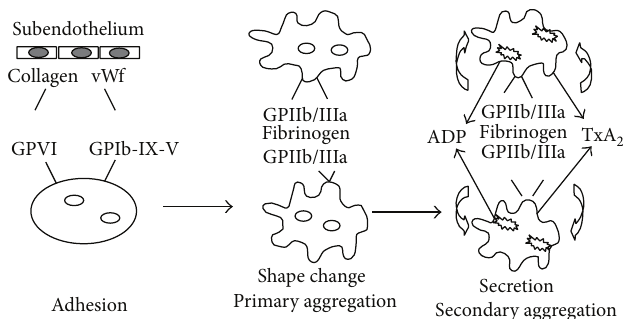
Figure 5: After an injury in the vessel wall, activation of platelets begins to start. It involves its adhesion to the subendothelium surface. Interaction between receptors like GPIb-V-IX, GPIa-IIa, and subendothelial compounds like vWf and collagen triggers the release of platelet granule contents accelerating aggregate formation.